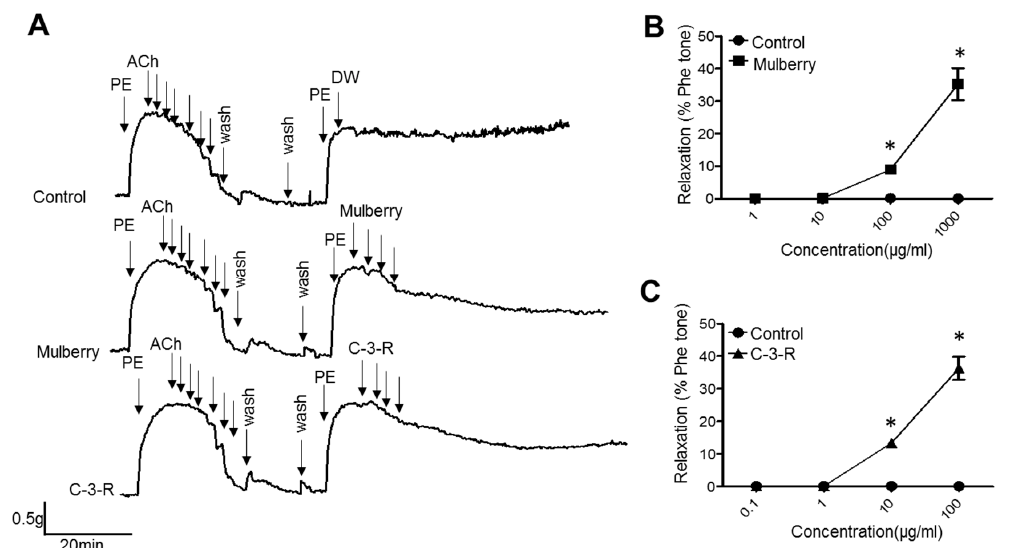
Figure 7. Extract and C-3-R enhances endothelial relaxation in aorta rings. ( A ) Representative tracings show that relaxation of rat thoracic aorta is induced by cumulative addition of 1 to 1000 µ g / mL mulberry and 0.1 to 100 µ g / mL C-3-G and C-3-R at the plateau of the phenylephrine (1 µ M PE)-induced contraction, followed by application of acetylcholine (ACh, 10 − 11 to 10 − 6 M). Concentration-response curve of endothelium-intact aortic ring relaxation following mulberry treatment ( B ) and C-3-R ( C ) was expressed as a % of the PE-induced contraction. Results are expressed as percent relaxation ± SEM. ( n = 5; * p < 0.05 vs. control). PE; phenylephrine